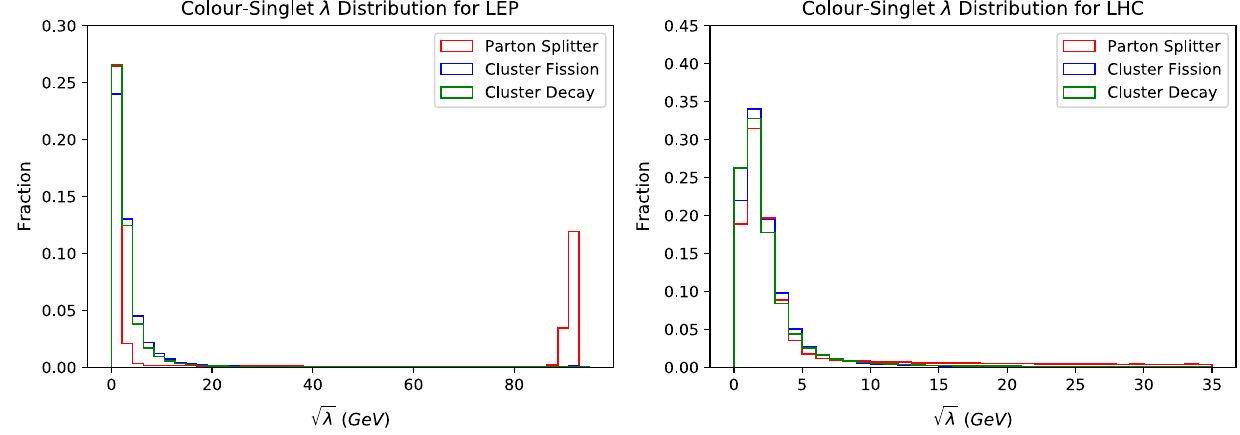
Fig. 7 Threshold mass, λ , distributions for colour-singlet systems immediately before the Parton Splitter, Cluster Fissioner, and Cluster Decayer steps at LEP events at 91.2 GeV and LHC Minimum Bias events at 7